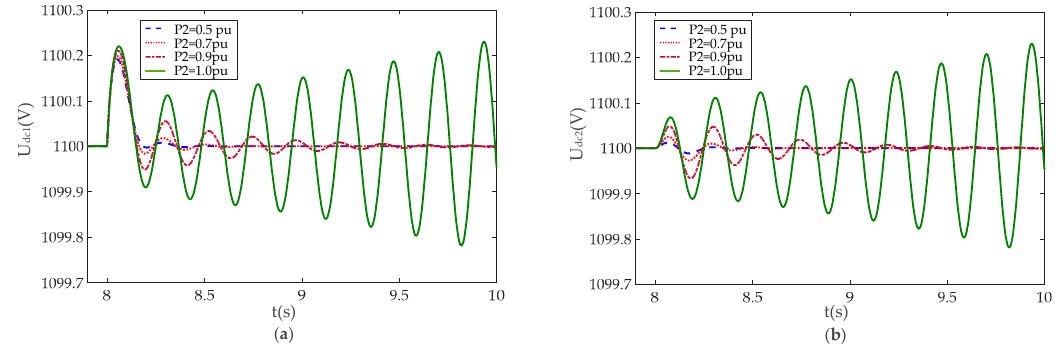
Figure 13. DC ‐ link voltage responses under different VSC2’ power outputs in ( a ) VSC1, ( b ) VSC2. Figure 13. DC-link voltage responses under di ff erent VSC2’ power outputs in ( a ) VSC1, ( b ) VSC2.